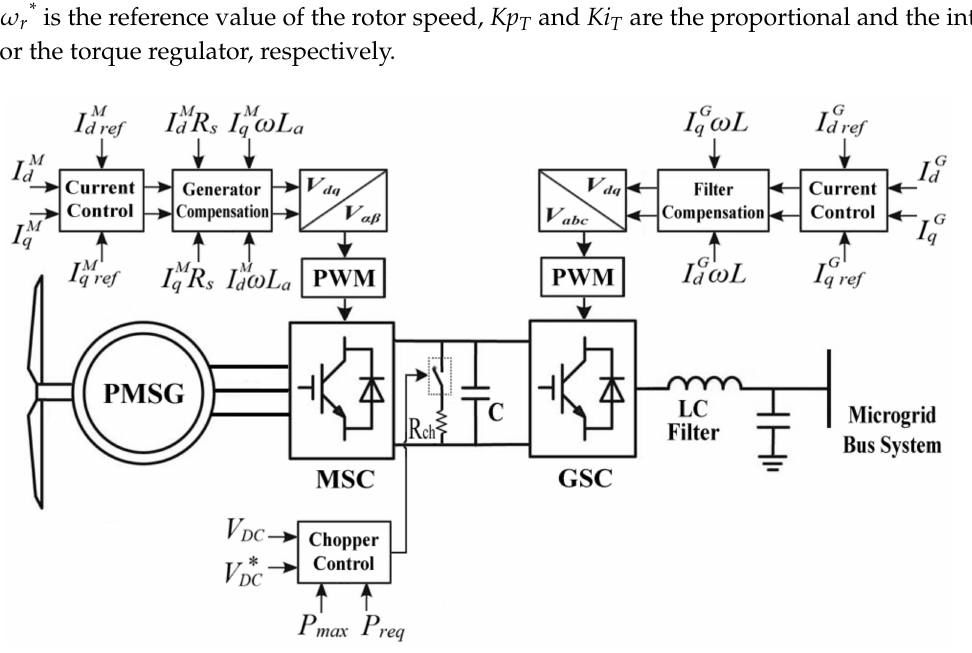
Figure 3. Structure and control system of WECS 2.